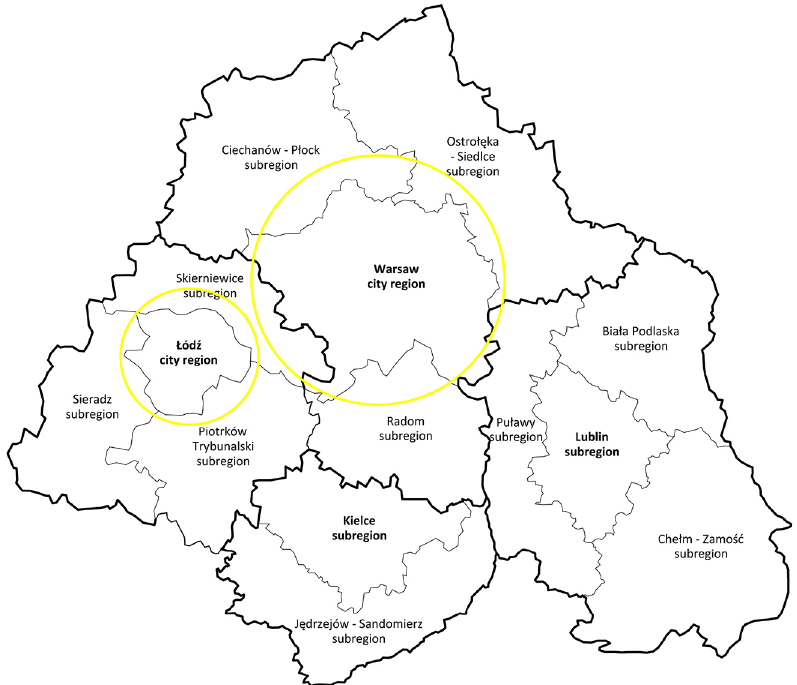
Fig. 3. Analysed subregions. The two city regions defined for this research are marked in yellow circles. Source: own